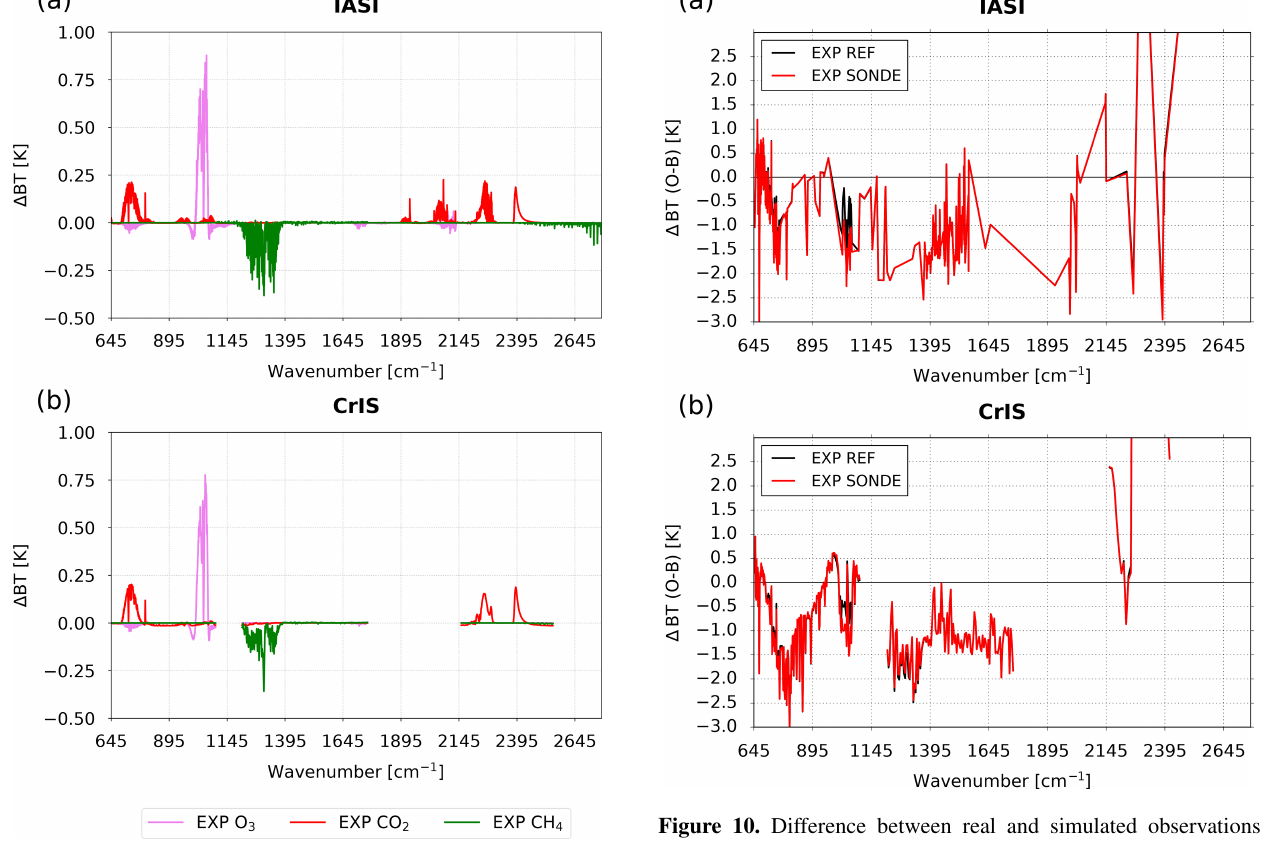
Figure 9. Difference between simulated brightness temperature (BT) with O 3 in purple (CO 2 in red and CH 4 in green) in situ pro- files from SONDE and AMULSE and simulated brightness temper- ature with O 3 (CO 2 and CH 4 ) reference profiles for in situ sounding from 17 April 2018 at 10:00UTC for all channels contained in the IASI (a) and CrIS (b) spectrum.